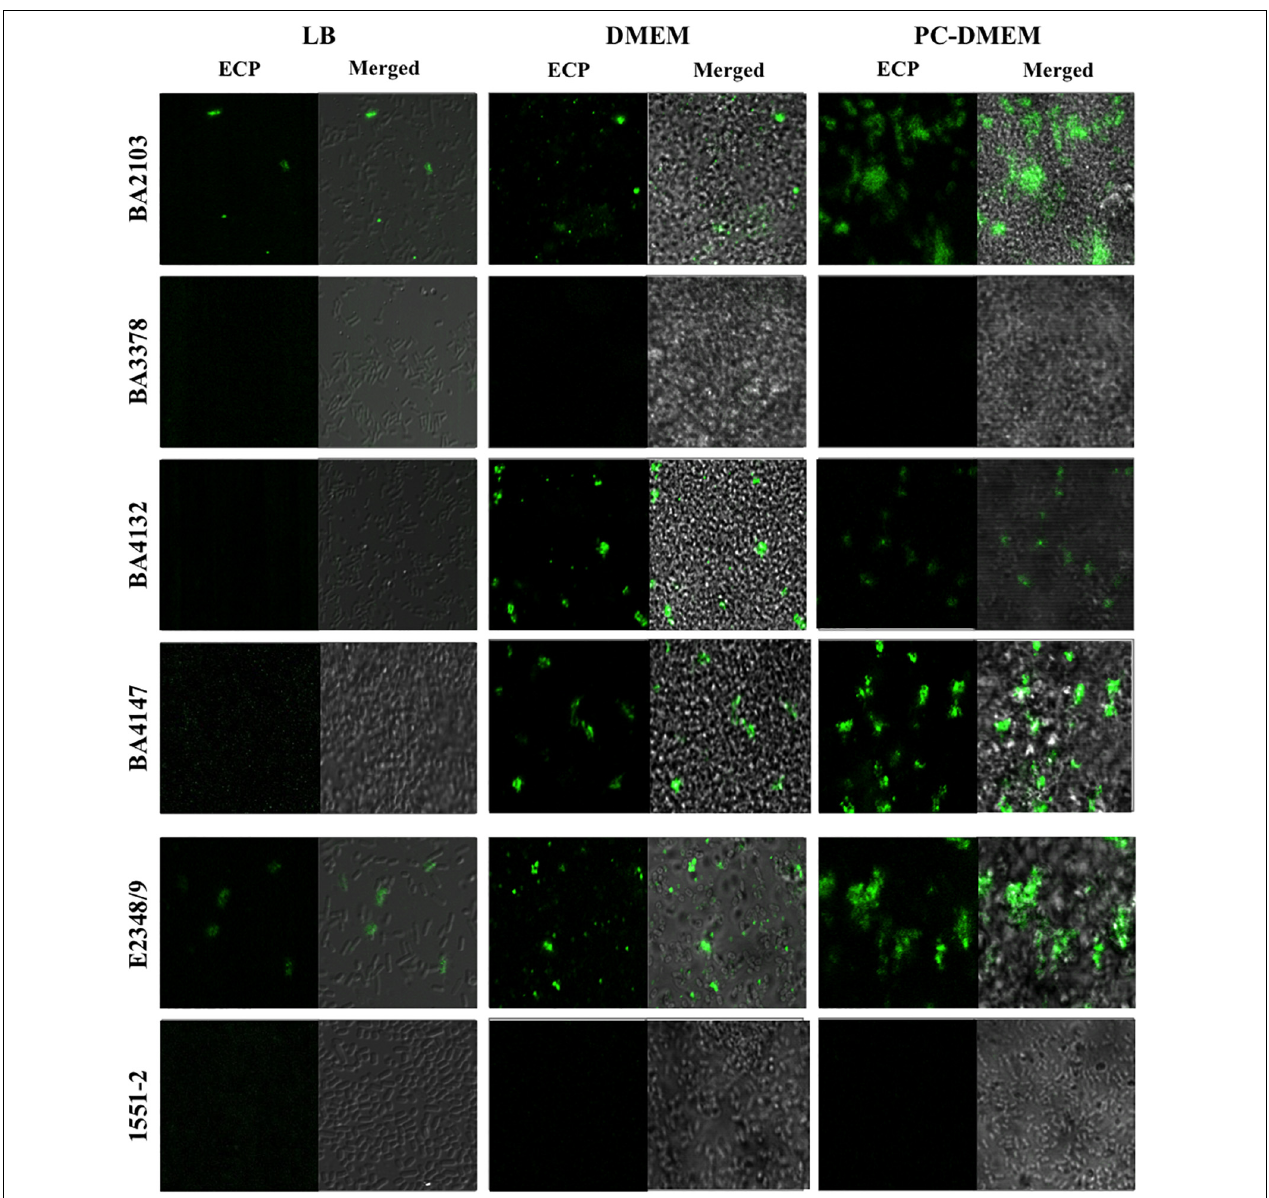
FIGURE 2 | Growth medium-dependent production of ECP visualized by confocal microscopy. aEPEC strains BA2103, BA3378, BA4132, BA4147 grown in LB, DMEM, and PC-DMEM were reacted with rabbit anti-EcpA antibody and goat anti-rabbit IgG antibody conjugated with FITC. E2348/69 and 1551-2 were used as positive and negative controls of ECP production, respectively. Images were originally taken at 1,000 ×